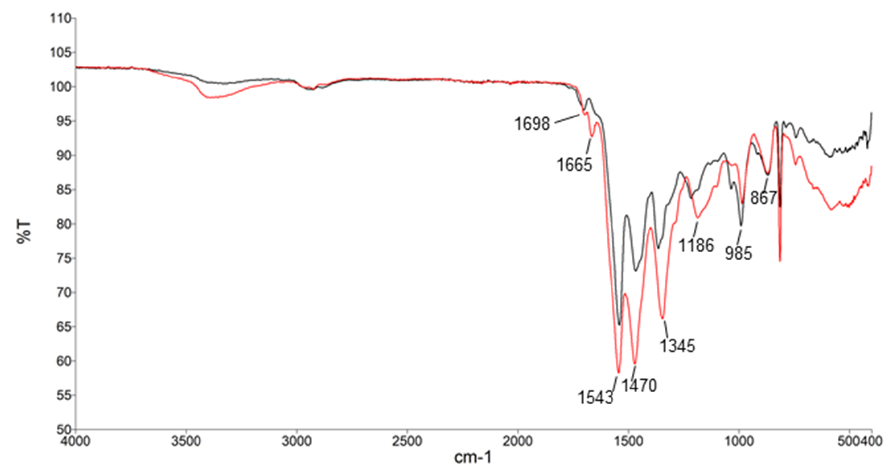
Figure 1. FTIR spectra of POP1 (black line) and POP2 (red Line).